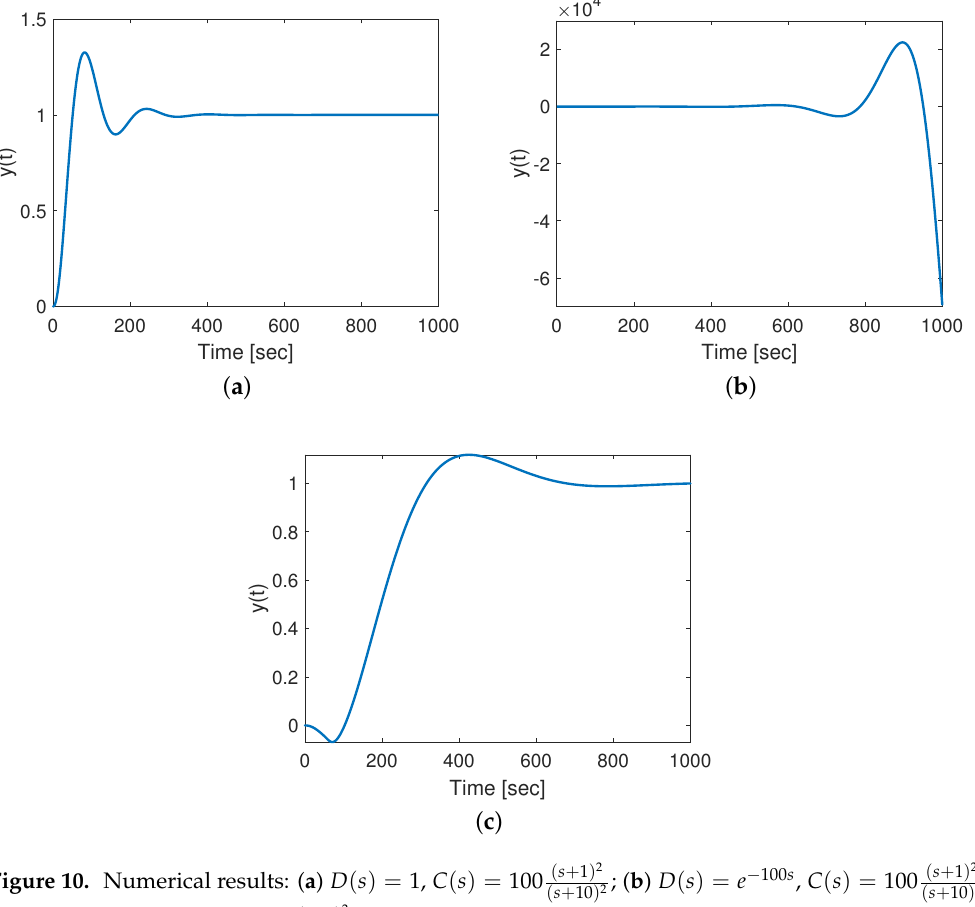
Figure 10. Numerical results: ( a ) D ( s ) = 1, C ( s ) = 100 ( s + 1 ) ( c ) D ( s ) = e − 100 s , C ( s ) = 10